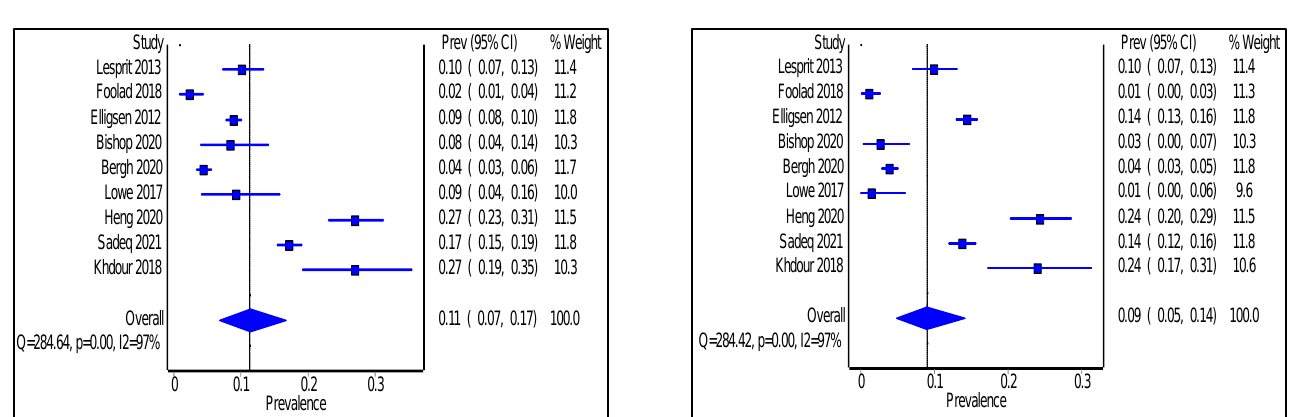
Figure 6. Prevalence of mortality within the inpatient setting in non-intervention and intervention groups.